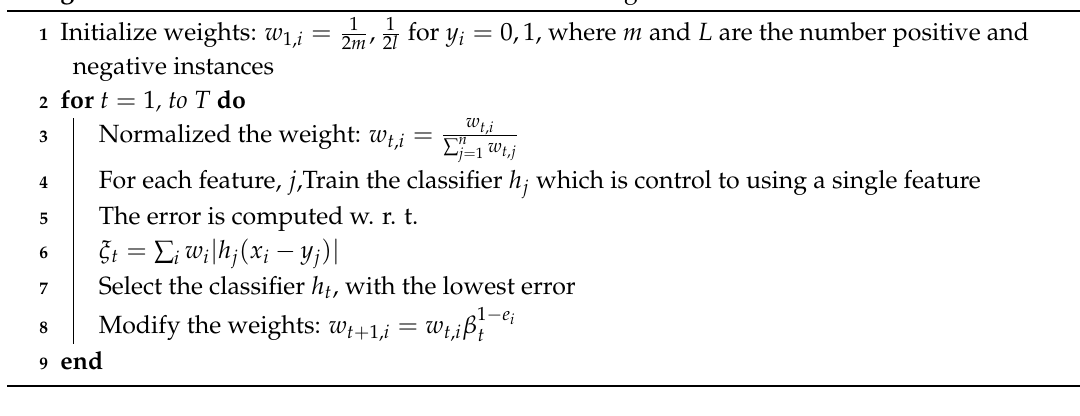
Algorithm 3: Ensemble Random Forest FS Algorithm.